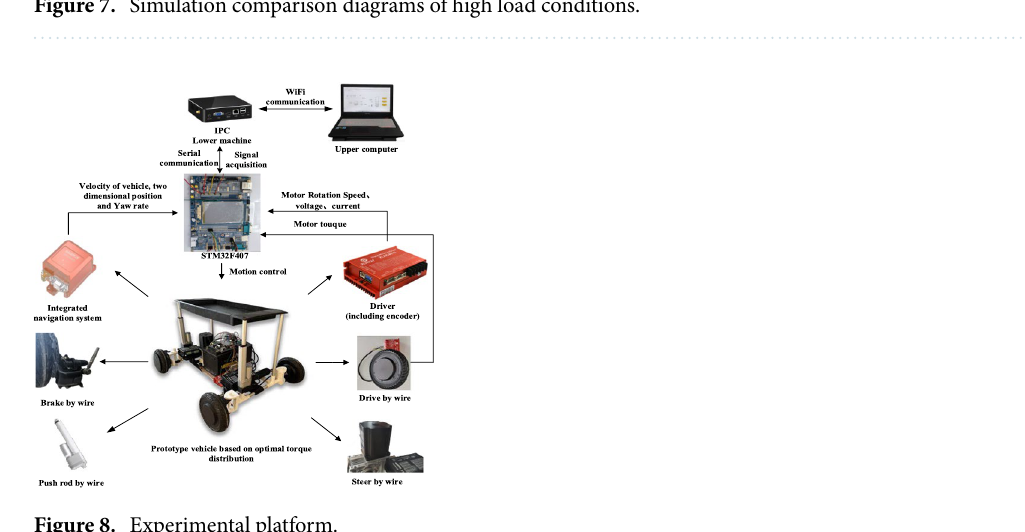
Figure 8. Experimental